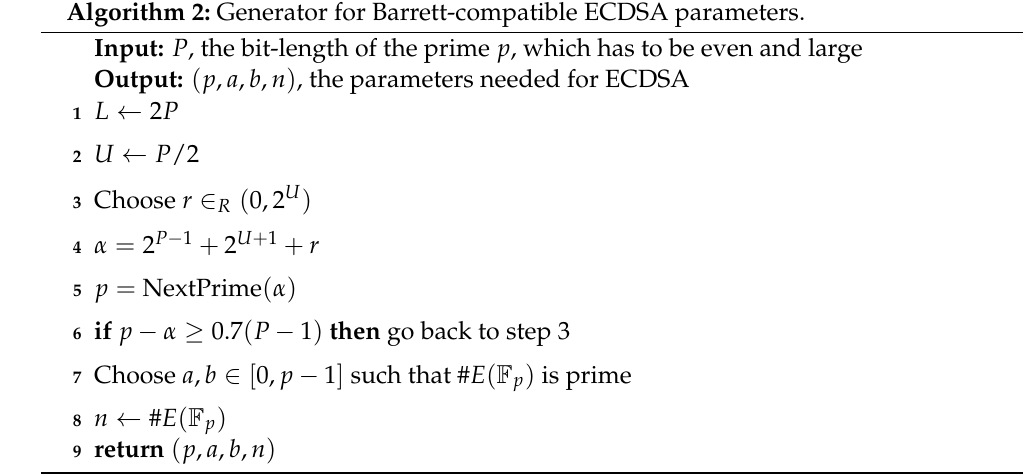
Algorithm 2: Generator for Barrett-compatible ECDSA